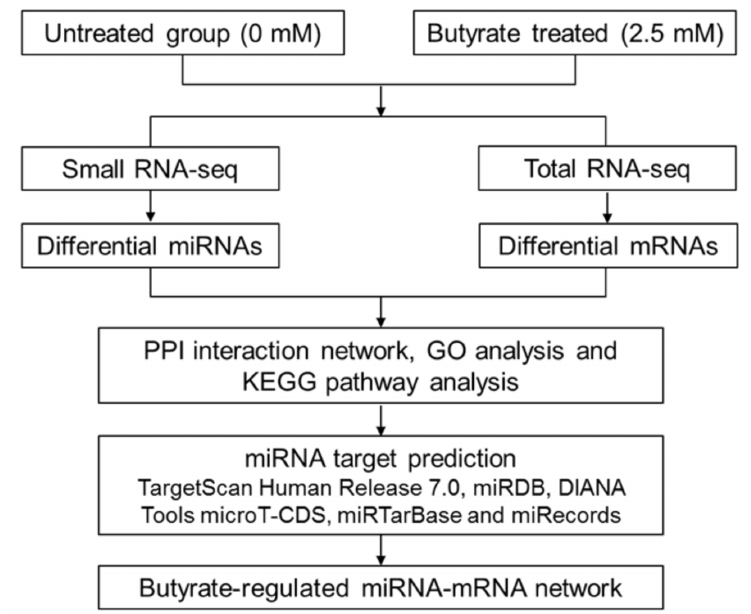
Figure 14. Flow chart of miRNA-mRNA network construction associated with the butyrate response in CRC cells. PPI network, protein–protein interaction network; GO analysis, gene ontology analysis; KEGG pathway analysis, Kyoto Encyclopedia of Genes and